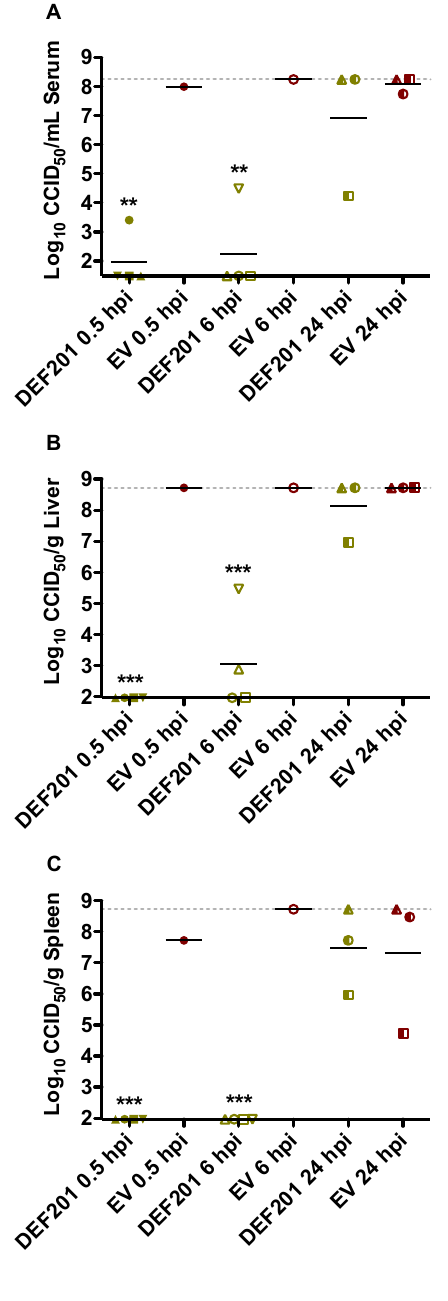
Figure 6. Post-exposure intervention with DEF201 within 6 h of RVFV challenge effectively reduces serum and tissue viral titers. Subgroups of hamsters (n = 4/group) treated and infected in parallel to the animals in the observation groups described in Figure 4 were sacrificed on day 2 post-infection for analysis of ( A ) serum, ( B ) liver, and ( C ) spleen virus titers. Several groups have less than 4 data points due to death prior to time of sacrifice. The gray hashed lines represent the saturation level indicating that actual titers are equal to or greater than the plotted concentration. * p < 0.05, ** p < 0.01, ***p < 0.001 compared to the 24 hpi EV